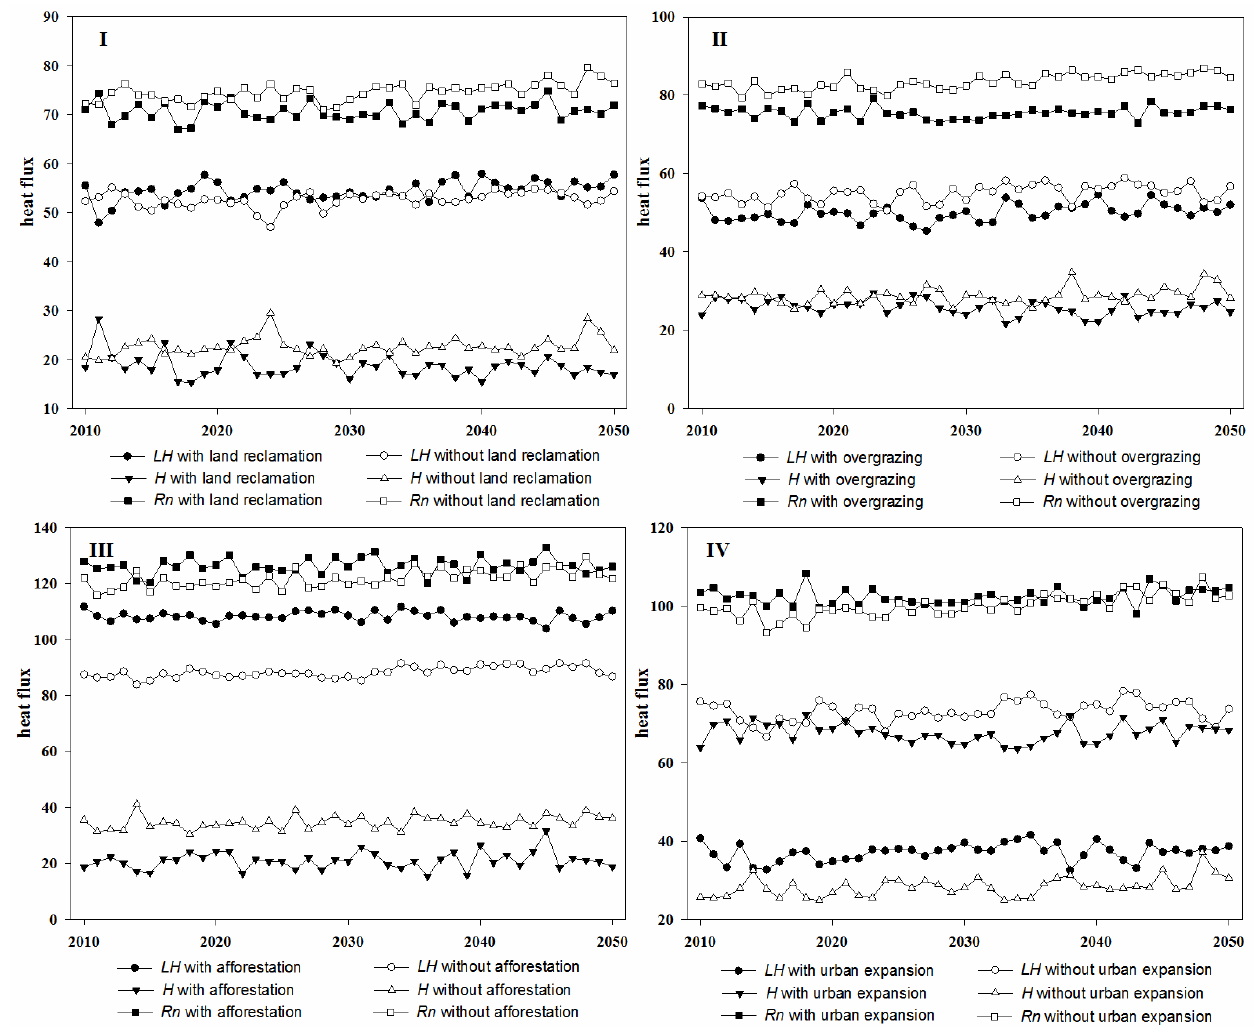
Figure 6. Annual average changes of latent heat flux ( LH ), sensible heat flux ( H ) and net radiation ( Rn ) in the grids with LUCC from 2010 to 2050. I: reclamation; II: overgrazing; III: afforestation; IV: urban expansion (Unit: W/m 2